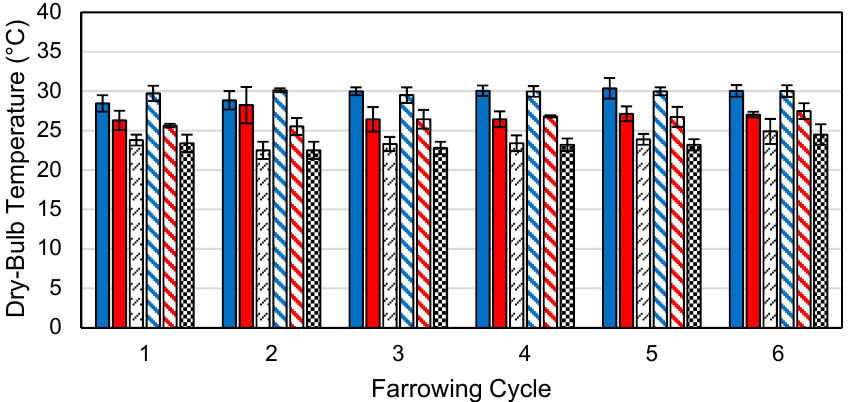
Figure 6. Average dry-bulb temperature of the creep area microclimate by heat source and room macroclimate (A and B) by farrowing cycle. Error bars represent one standard deviation of the mean.